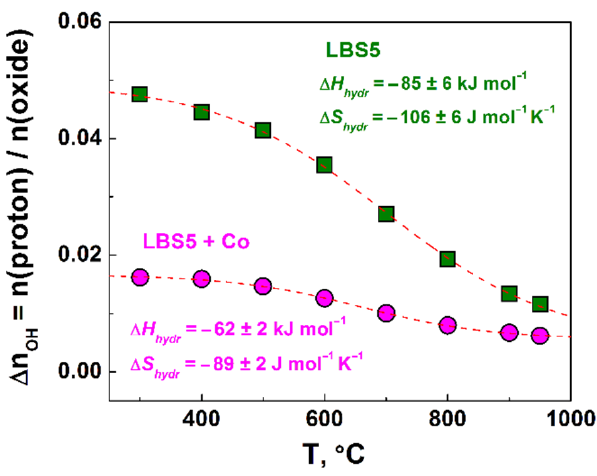
Figure 10. Proton concentrations in La 0.95 Ba 0.05 ScO 3- δ and La 0.95 Ba 0.05 ScO 3- δ + 0.5 wt% Co 3 O 4 samples.